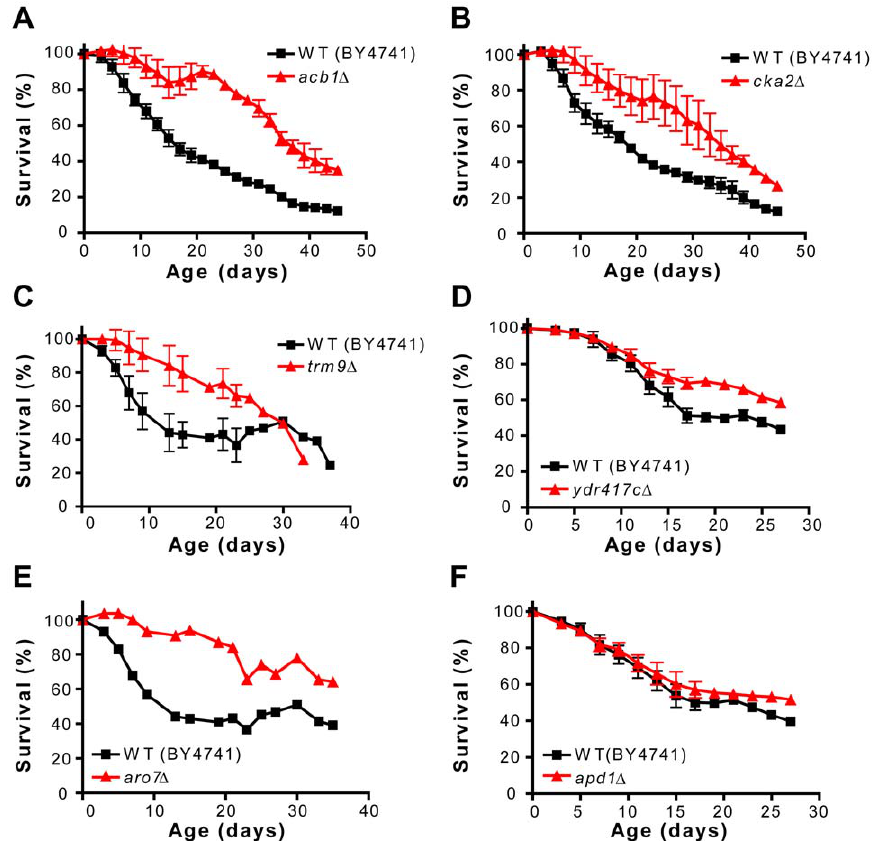
Figure 3. Novel long-lived mutants. CLS of cultures under starvation/extreme CR of wild type (BY4741) and (A) acb1 D , (B) cka2 D , (C) trm9 D , (D) ydr41c D , (E) aro7 D , and (F) apd1 D mutants. All figures show an average of 2–3 experiments except (F), which shows a representative experiment. The CFUs at day 3 before cells were transferred to water were: 131.3 6 5.1, 129.8 6 7.2, 111 6 8, 77.1 6 8.1, 169 6 2, 48.1 6 4.8, 152.1 6 3.3 (cells 6 10 6 / mL 6 SEM) for wild type, acb1 D , cka2 D , trm9 D , ydr41c D , aro7 D , and apd1 D , respectively.